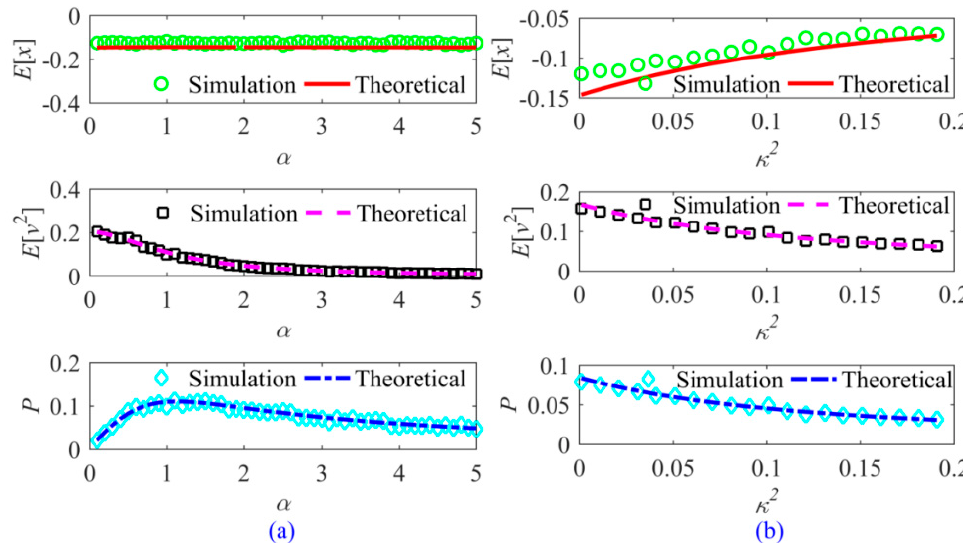
Figure 3. Influence of ( a ) time constant ratio and ( b ) electromechanical coupling coefficient on the mean displacement, mean square voltage, and power output.